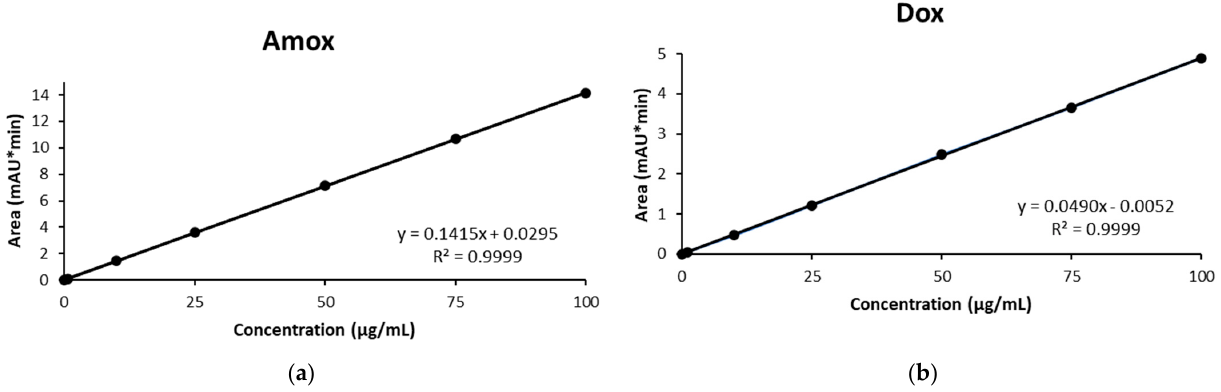
Figure 3. HPLC calibration curves of ( a ) Amox and ( b ) Dox